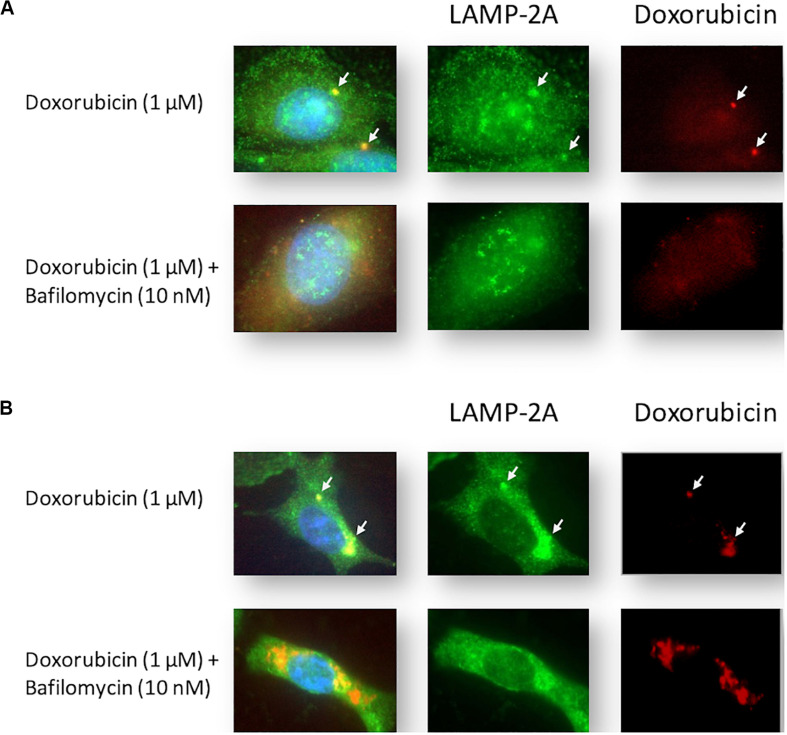
Intracellular localization of LAMP-2A and Dox in Dox-treated MCF12A and MDAMB231 cells following autophagy inhibition. Representative images of LAMP-2A staining (green) and Dox (red) within MCF12A (A) and MDAMB231 (B) cells in the presence of Dox alone or in combination with Baf. Arrows highlight regions of localized Dox accumulation overlapping with regions of punctate LAMP-2A signal. Comparative control groups (cells treated with Dox in the presence of amino acids) are shared between Figure 4 and Figure 7 since treatment groups from both figures were performed together in one experiment. Images were obtained using a 40× objective.